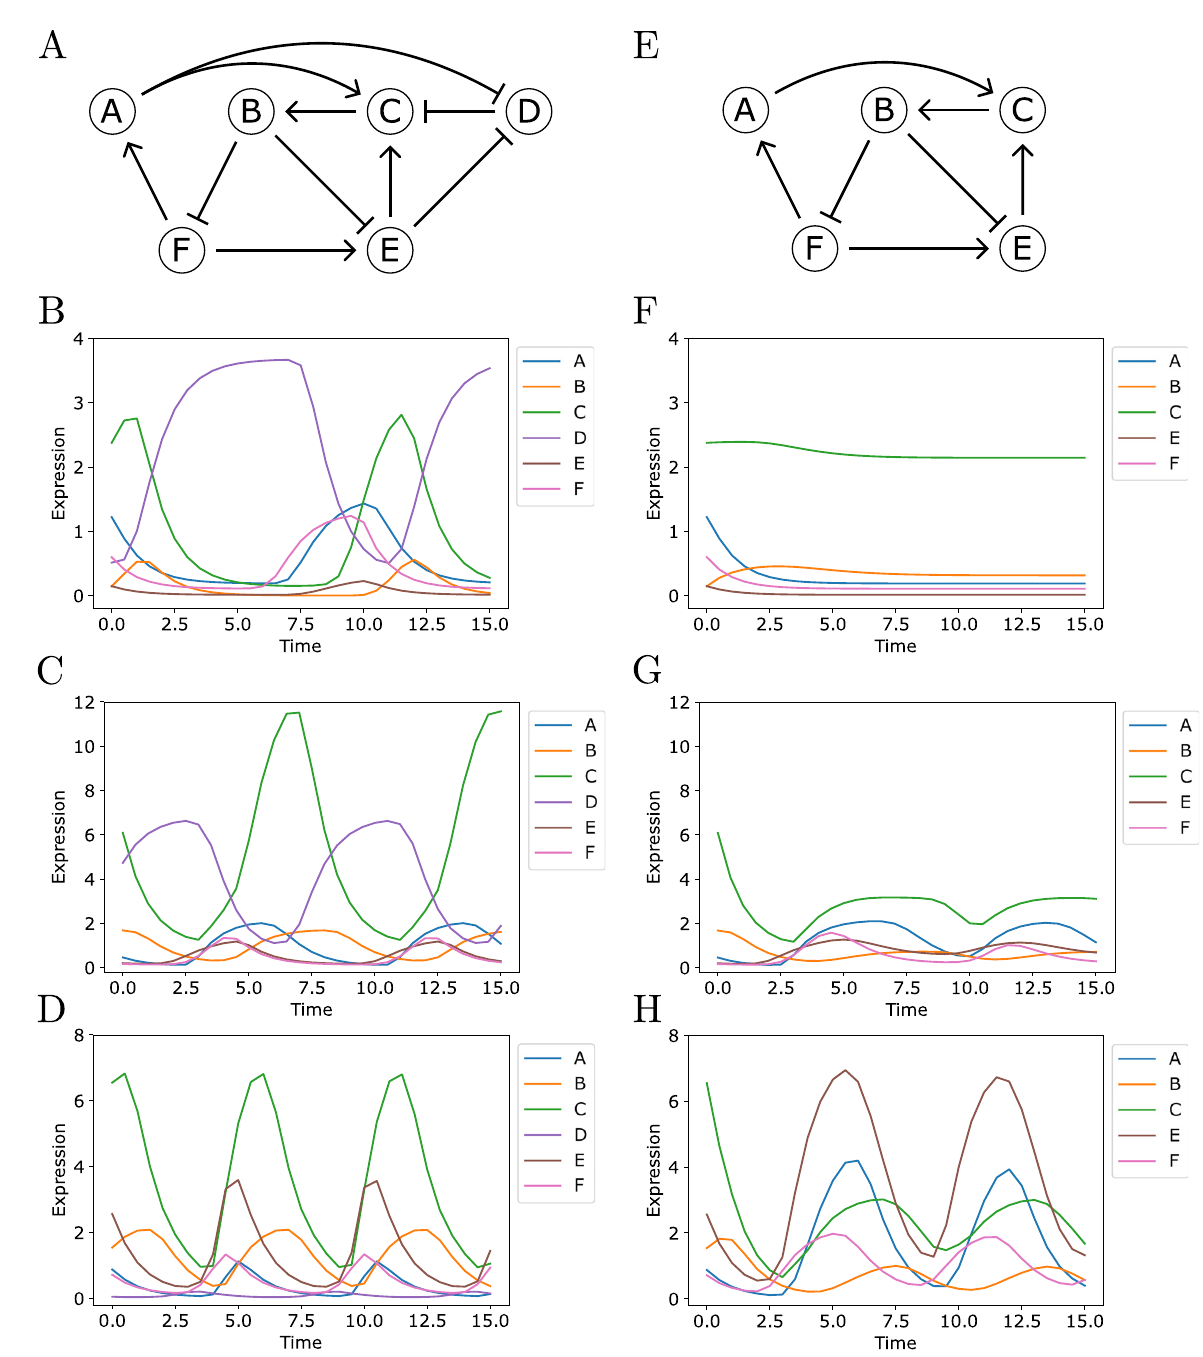
Fig 3. Panel A. Ground truth regulatory network, where sharp arrows indicate activation (or positive regulation) and blunt arrows indicate repression (or negative regulation). Panels B-D. Synthetic time series from 3 different parameterizations of a single Hill model (see Methods Section 4.4.1). Panel E. The subnetwork formed from the network in panel A of this figure by removing the node D. Panels F-H. Synthetic time series from the same parameters as in panels B-D of this figure, but excluding node D.